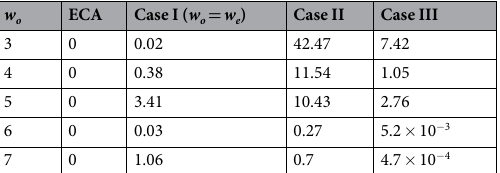
Table 3. Percentage of sampled cases displaying OEE (satisfying Definitions 1 and 2) for each CA variant. Rows are organism width, w o , and columns correspond to the three different CA variants and ECA